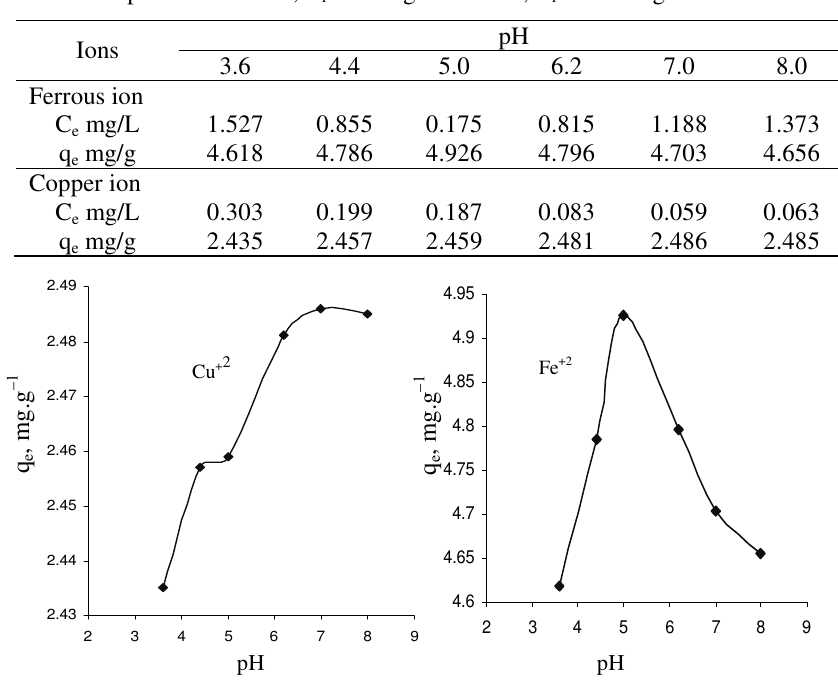
Table 1 . Equilibrium parameters for the adsorption of metal ions onto pine fruit powder at different pH.